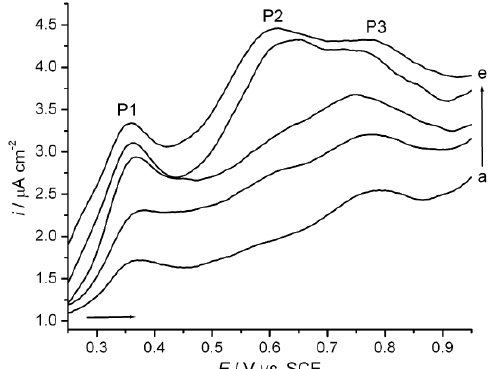
Figure 3. Differential pulse voltammograms of red wines: ( a ) Frankovka, ( b ) Pinot noir, ( c ) Zweigelt, ( d ) Plavac Hvar, ( e ) Ivan Dolac, diluted 1/400 in acetate buffer solution pH3.6, measured at the GC electrode. Scan rate, 5 mV s − 1 , from Seruga et al . [49] (with permission from